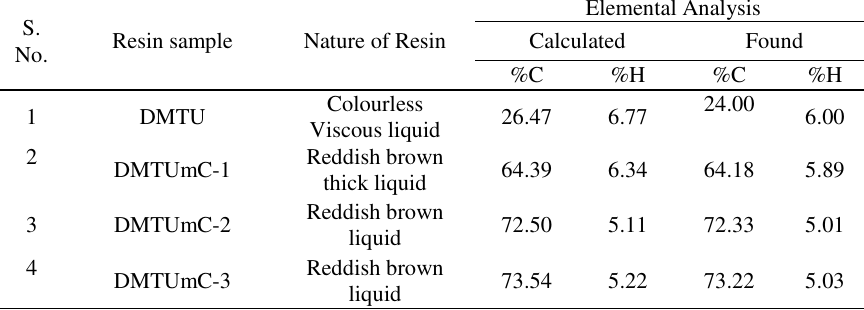
Table 1 . Elemental analysis of N,N'-Dimethylolthiourea – m-Cresol resin